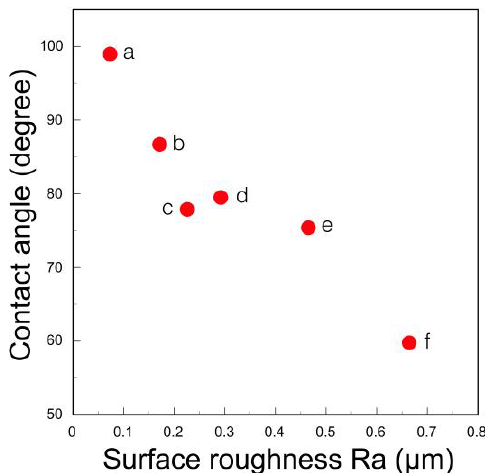
Figure 21. Contact angle of distilled water on surface treated zirconia. ( a ) Millar polish with a diamond paste; ( b ) grinding with a fine diamond bar; ( c ) grinding with a medium diamond bar; ( d ) grinding with #800 abrasive paper and fired; ( e ) grinding with a course diamond bar; and ( f ) sandblast with alumina. Adopted from Ref. [68].